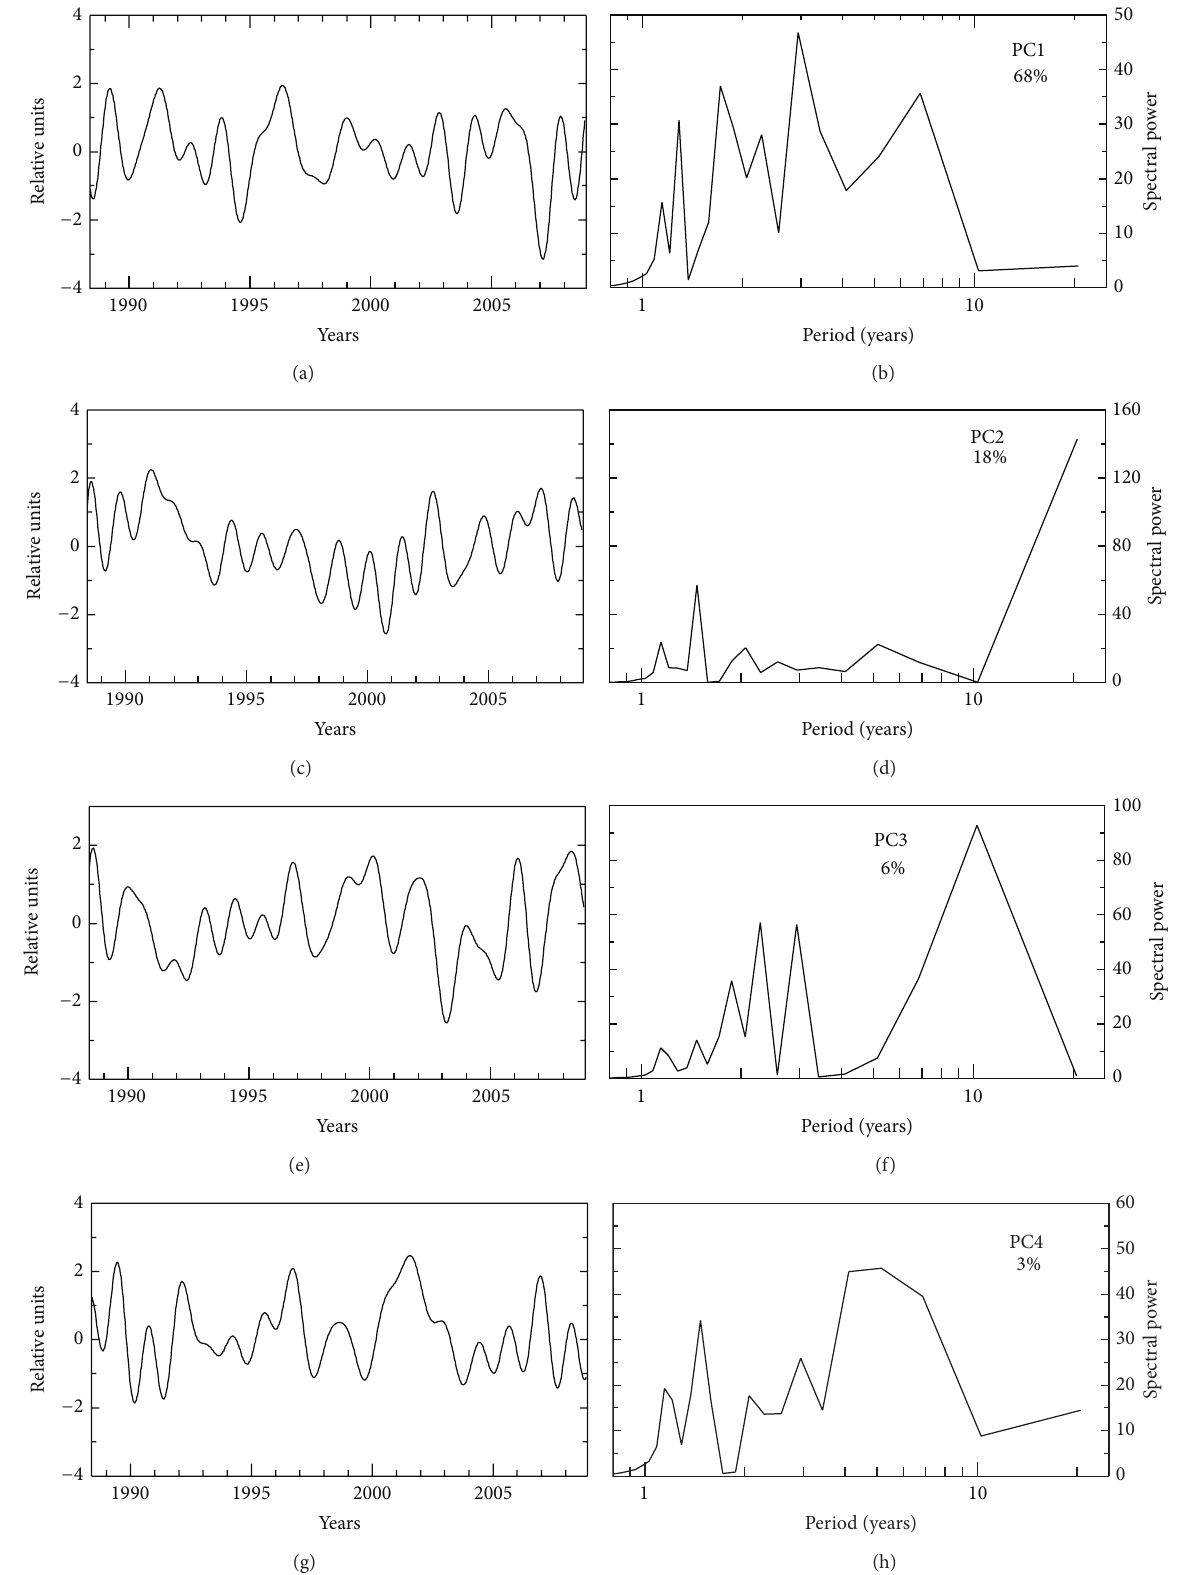
Figure 6: PCs of matrix F 2 corresponding to the EOFs of the lower part of Figure 4 are exhibited analogously to the same parameters of the matrix F 1 in Figure